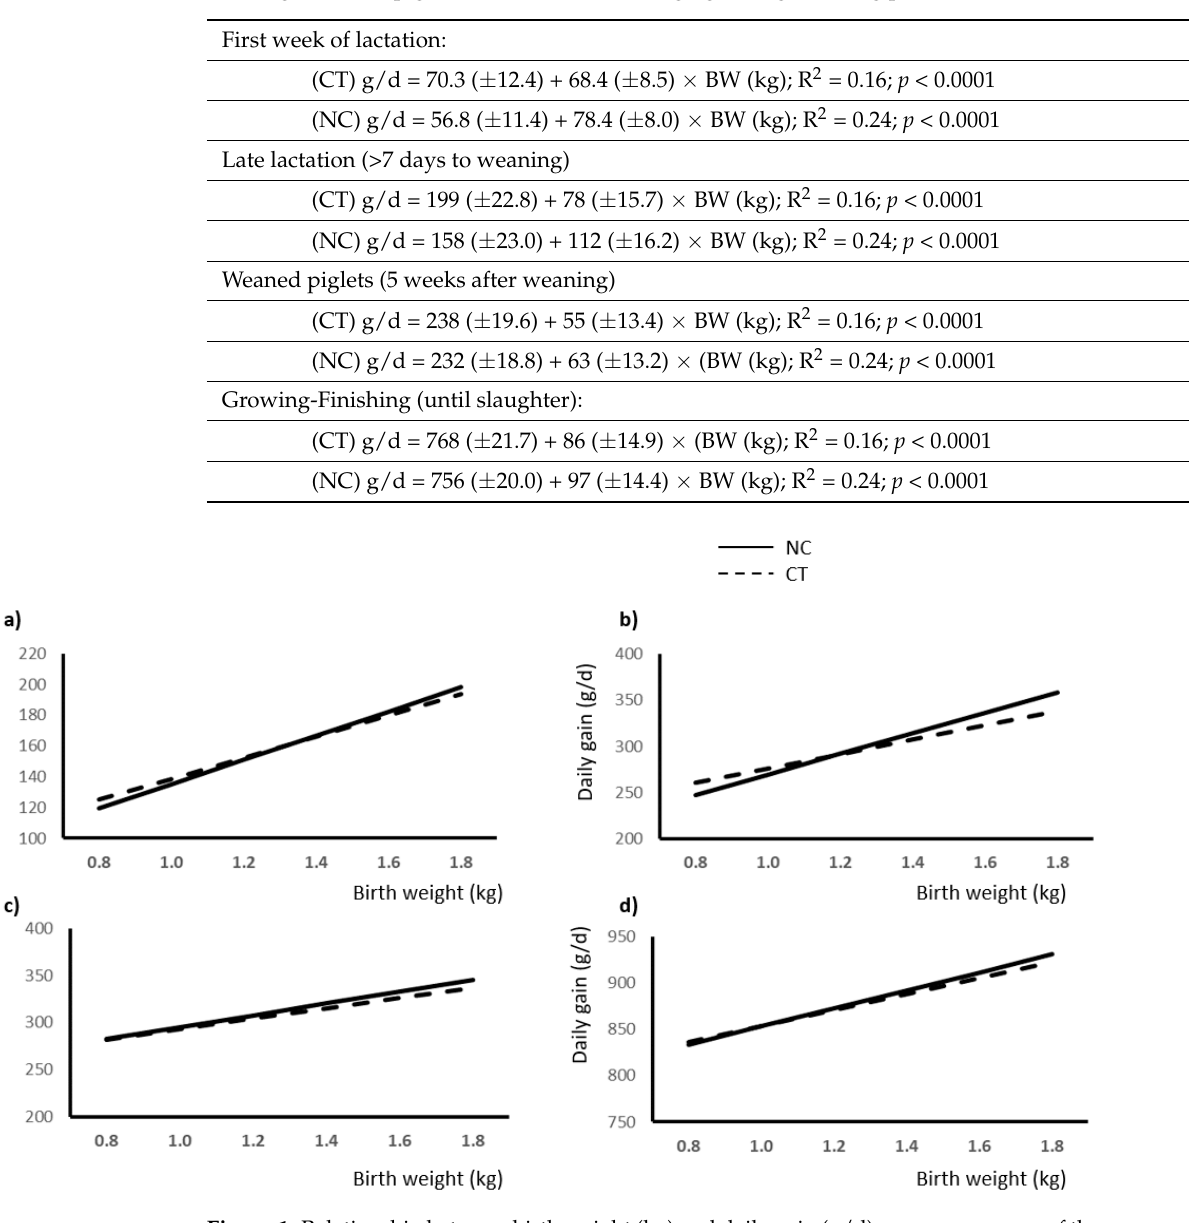
Figure 1. Relationship between birth weight (kg) and daily gain (g/d) as a consequence of the presence (NC) or absence (CT) of neonatal care during: ( a ) first week of lactation; ( b ) late lactation (>7 days until weaning); ( c ) weaned piglet (5 weeks after weaning); ( d ) growing-finishing